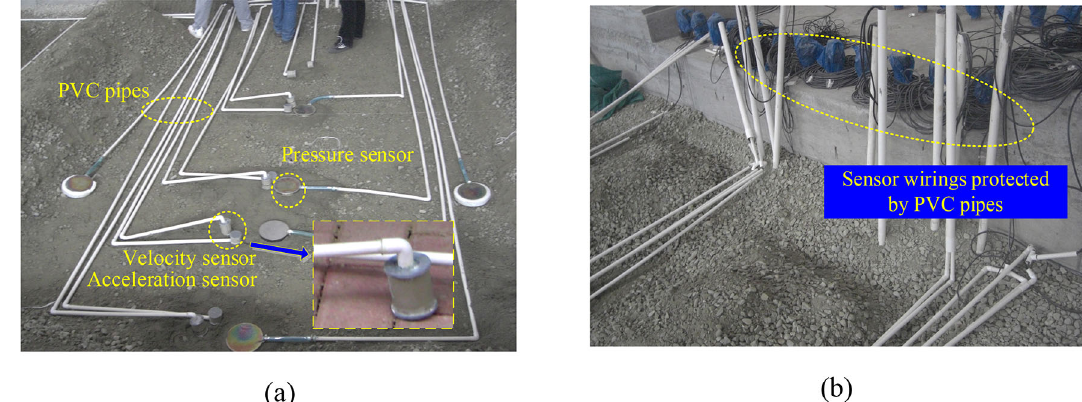
Fig. 10 Sensor layout process in subgrade: a sensor layout; b sensor